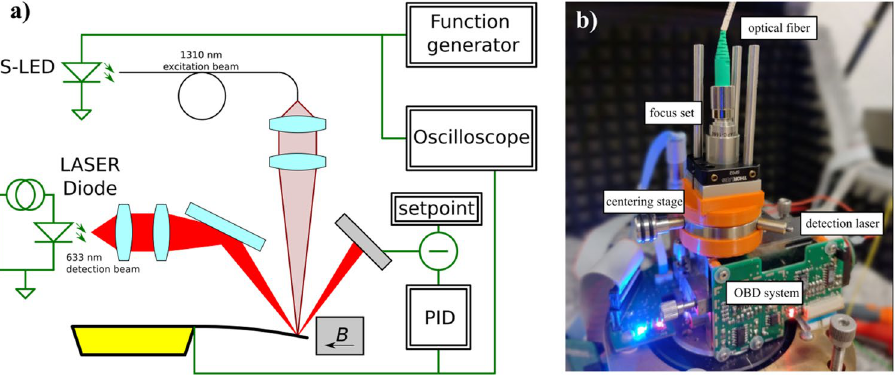
Figure 1. Experimental setup: ( a ) schematic of the setup with electrical and optical signals; ( b ) optical part of the